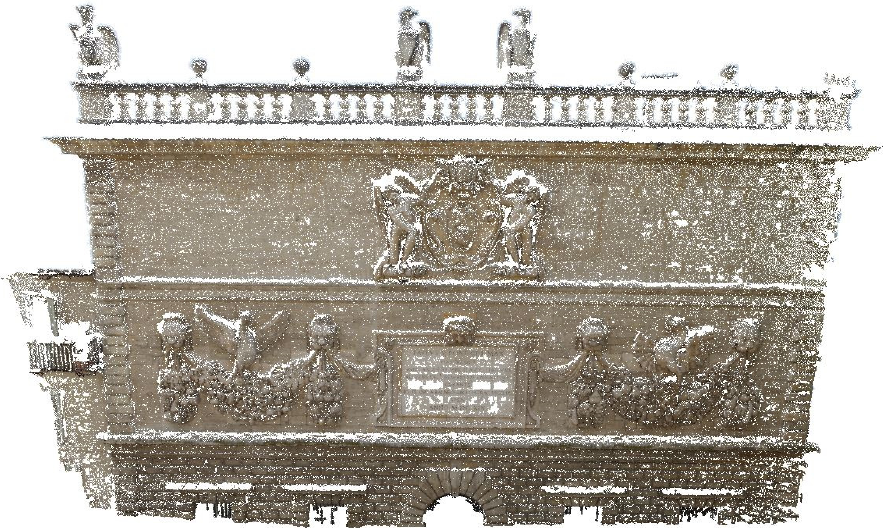
Figure 13. MVS data of the Hotel sequence that was generated by the PMVS. The dense point clouds are very accurate. This is attributed to use of the HashMatch method.